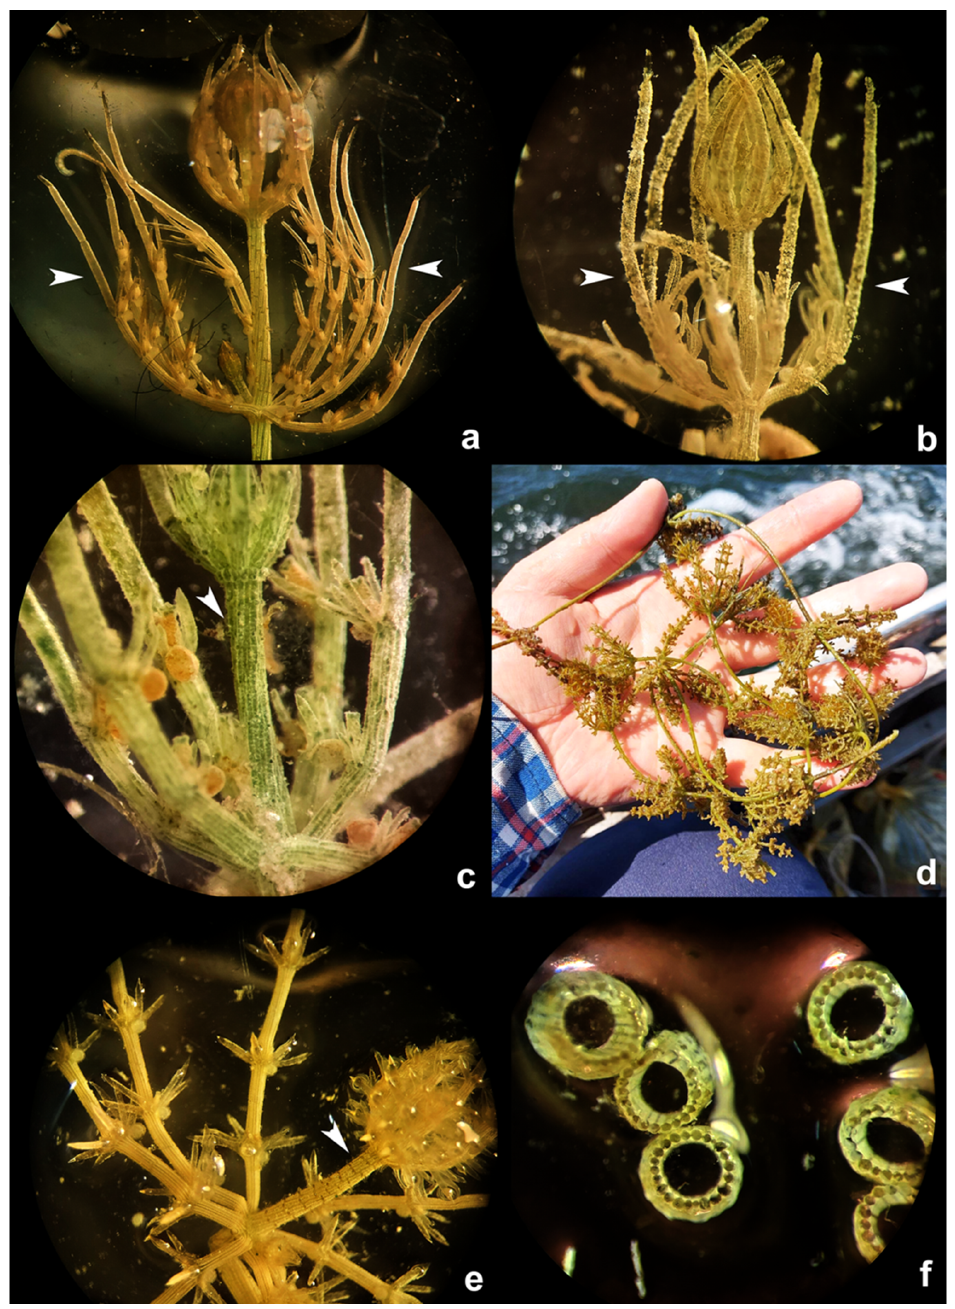
Figure A3. Chara contraria ( a – c ), C. dominii ( d – f ): ( a )—upper part of a plant with clearly tylacanthous stem cortex and branchlets with ecorticate nodeless part (arrowheads) slightly shorter of corticated differentiated branchlet part with posterior bract cells up to 3.5(4) longer of oogonium, Kapchagay Reservoir, ( b )—upper part of a plant with branchlets with ecorticate nodeless part (arrowheads) 3- times longer of corticated differentiated branchlet part, Lake Anniversary, ( c )—base of branchlets with posterior bract cells more or less equal to slightly longer of oogonium, clearly tylacanthous stem cortex with solitary papillose spine cells (arrowhead), Canal Bakanas, ( d )—general habit, Canal Arystan, ( e )—upper part of plants with long squarrose verticillate bract cells, elongated acute stipulodes, tylacanthous stem cortex with short acute mainly solitary spine cells (arrowhead), Canal Arystan, ( f )—cross-section of stems shoving nearly isostichous stem cortex, Canal Arystan. All photos by G. Jumakhanova.